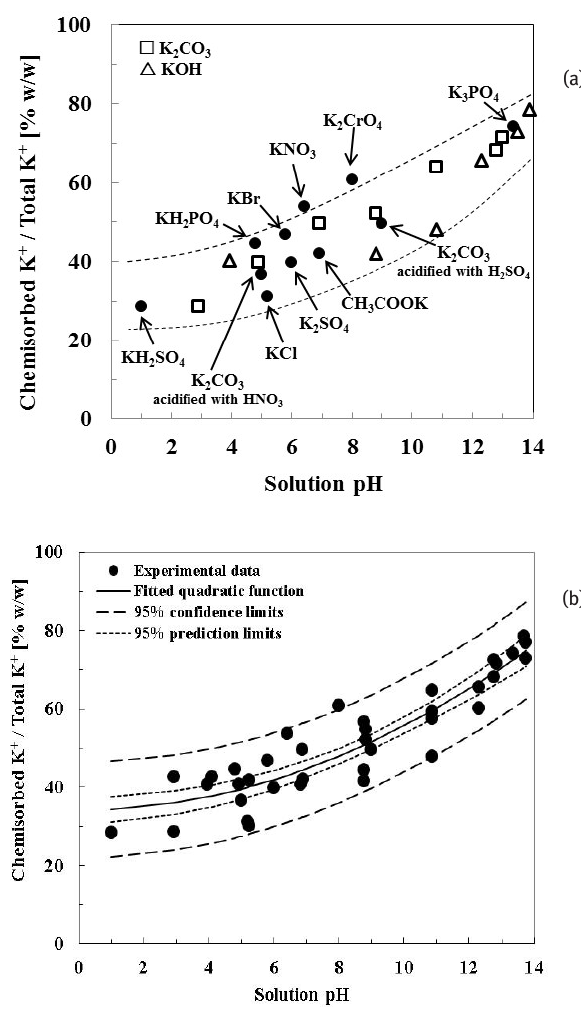
Figure 1: Effect of the solution pH on the fraction of the chemisorbed potassium for various impregnating solutions (a) experimental results and (b) regression analysis